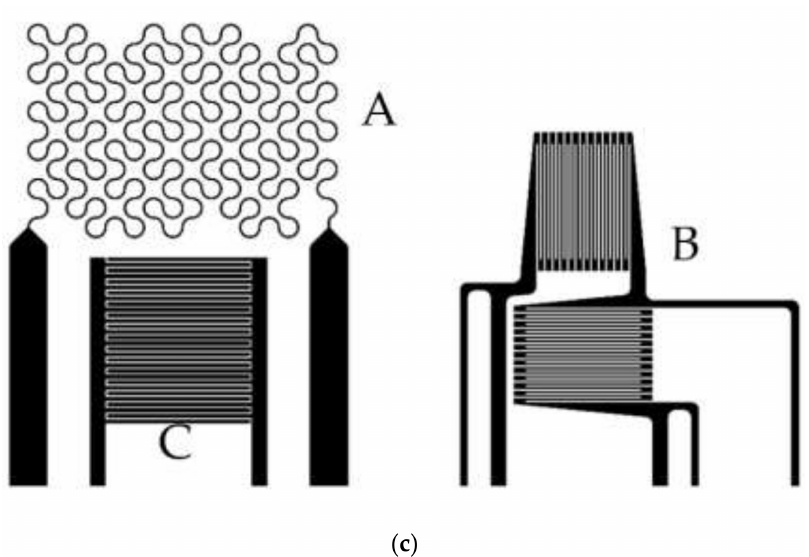
Figure 2. ( a ) Manufactured sensor nodes on a 4 (cid:48)(cid:48) glass wafer, next to the sensor structures also the metallic coating ring for better adhesion of the PEI film is visible; ( b ) sensor node on PEI foil released from the carrier; ( c ) schematic of sensor node design, consisting of SFC-temperature sensor (A), two strain sensors in half-bridge circuit (B), and an interdigitated electrode capacitance